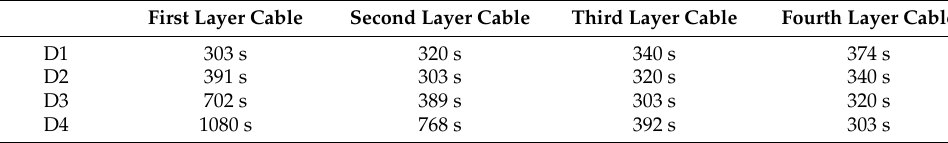
Table 5. Ignition time of cables at different ignition